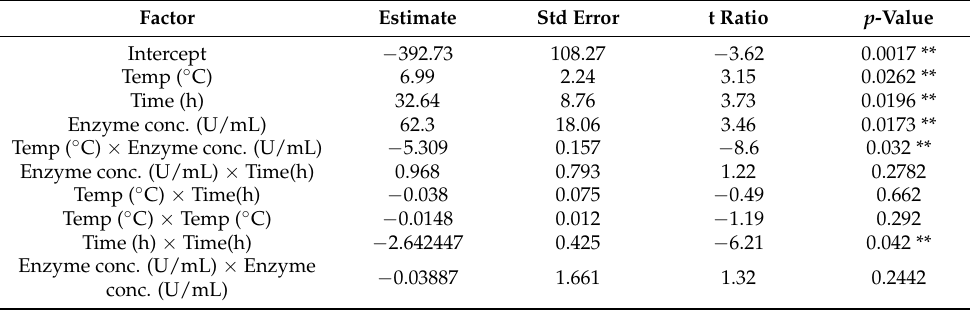
Table 14. Parameter estimates and summary of fit for Box–Behnken design. Factor